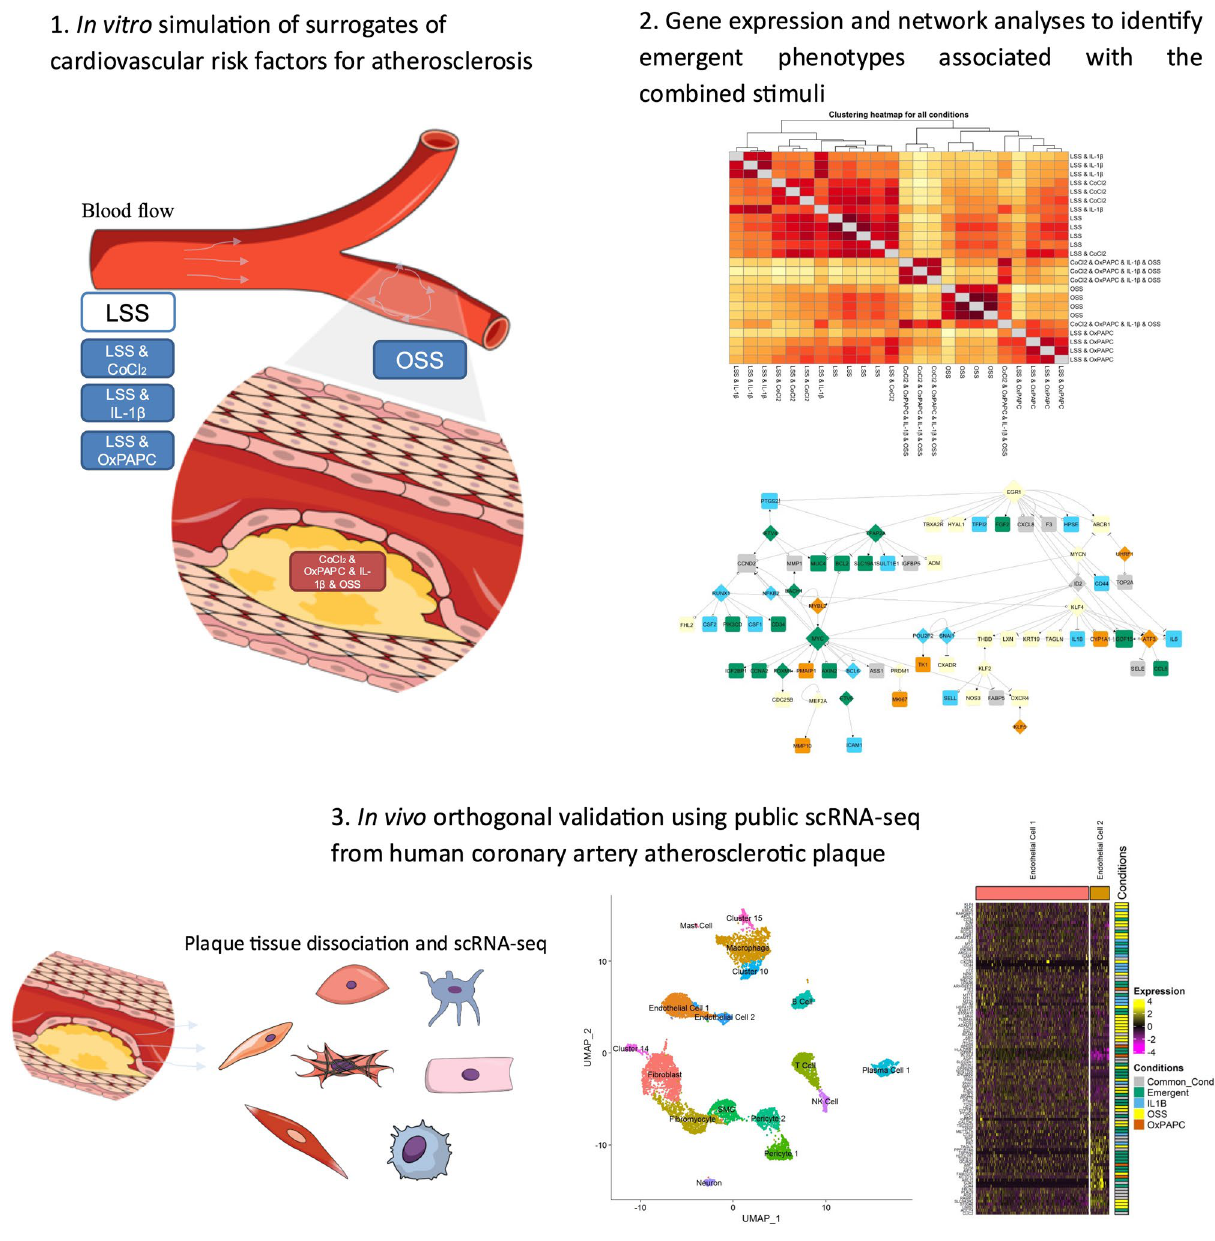
Figure 1. Overall workflow for the identification and validation of emergent phenotypes associated to the combined exposure to surrogates of CV risk factors such as hypoxia (CoCl 2 ), Oxidized lipids (OxPAPC), inflammation (IL-1β) and OSS on human coronary artery endothelial cells (HCAEC). 1 Experimental design for in vitro exposure of HCAEC to individual or combined stimuli. 2 Global gene expression and gene regulatory network analyses. 3 Orthogonal validation using scRNA-seq data from human coronary atherosclerotics plaques (dataset GSE131778). The cartoons were created using the Mind the Graph platform (www. mindt hegra ph. com) and data presented in the manuscript to illustrate the overall